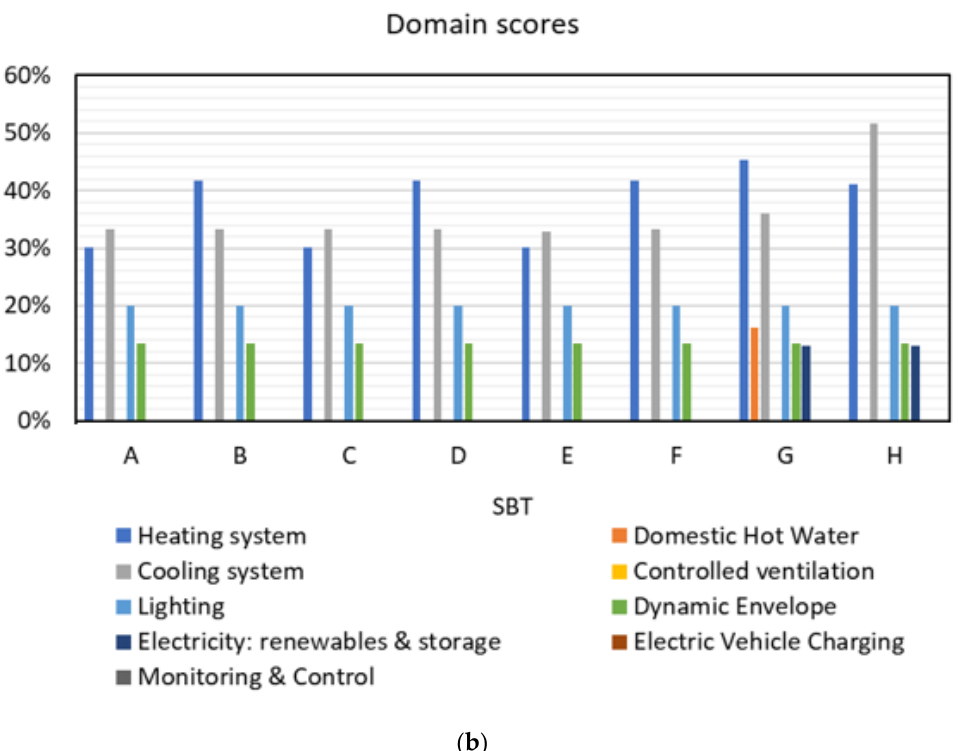
Figure 5. Impact and domain scores for each SBT in the “energy scenario”. ( a ) Impact scores and ( b ) domain scores.